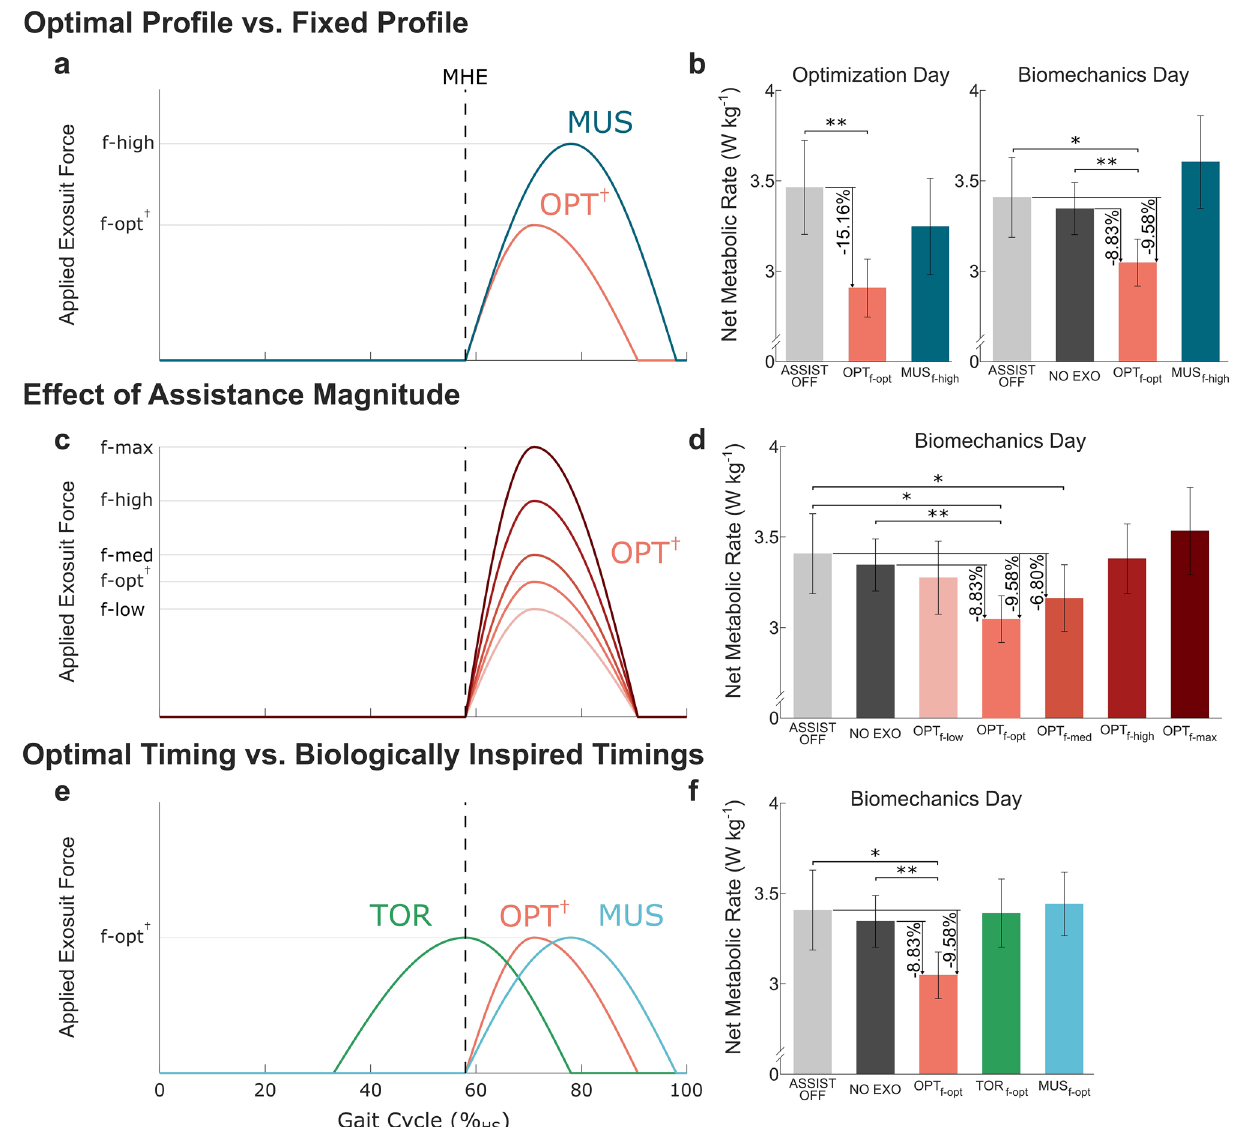
Figure 3. Metabolic results. ( a and b ) Comparison between the individualized optimal profile ( OPT f − opt ) identified on Optimization Day and a fixed profile ( MUS f − high ) that remains the same for all participants. Force profiles ( a ) and corresponding net metabolic rates ( b ) on Optimization Day (left) and Biomechanics Day (right). ( c and d ) Effect of assistance magnitude ( F peak ). Five different force magnitudes are evaluated: the optimal force ( f − opt † ), 60 N ( f − low ), 90 N ( f − med ), 120 N ( f − high ), and 150 N ( f − max ). The assistance timing for every profile is set to the optimal timing ( OPT † ). Force profiles ( c ) and corresponding net metabolic rates ( d ) on Biomechanics Day. ( e and f ) Effect of assistance timing. Three different assistance timings are evaluated: optimal timing ( OPT † ), biological torque inspired timing ( TOR ), and muscle activation inspired timing ( MUS ). The assistance magnitude of every profile is set to the optimal force ( f − opt † ). Force profiles ( e ) and corresponding net metabolic rates on Biomechanics Day ( f ). Error bars indicate the standard error of the mean (SEM). The vertical dashed lines represent the instant of MHE. † indicates an individualized parameter. Asterisks indicate statistically significant differences (n = 8, two-sided paired t tests; * P < 0.05; ** P < Table S2). The estimated metabolic reduction relative to NO EXO was 14.8 ± 2.7% (0.51 ± 0.13 W kg −1 ) based on the estimated metabolic cost of the 0.25 kg and 0.44 kg added to the participant’s waist and thigh respectively when wearing the textile components of soft exosuit (0.044 W kg −1 ) 54 . Subsequently, on the biomechanics day (Supplementary Video S2), the optimal profile resulted in a 9.6 ± 2.8% (0.36 ± 0.12 W kg −1 ; P < 0.05) reduction in net metabolic cost relative to the ASSIST OFF and an 8.8 ± 1.7% (0.30 ± 0.06 W kg −1 ; P < 0.01) reduction relative to NO EXO (Supplementary Table S3). The difference in net metabolic cost reduction between the opti- mization and biomechanics testing day could be attributed to exoskeleton assistance training and human motor adaptation 55 , a point expanded upon in the discussion. The fixed profile did not show a statistically significant change in metabolic cost relative to baseline on either the optimization or biomechanics day, providing further